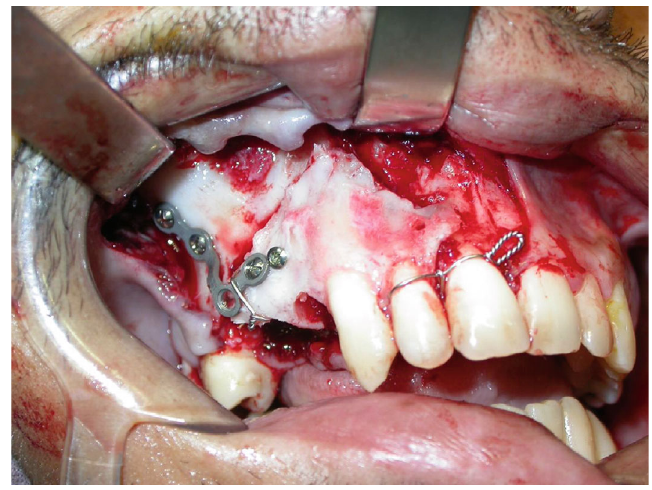
Figure 6: Functional reduction of the fragment with the aid of the “ L ” plate and 2.0 system titanium